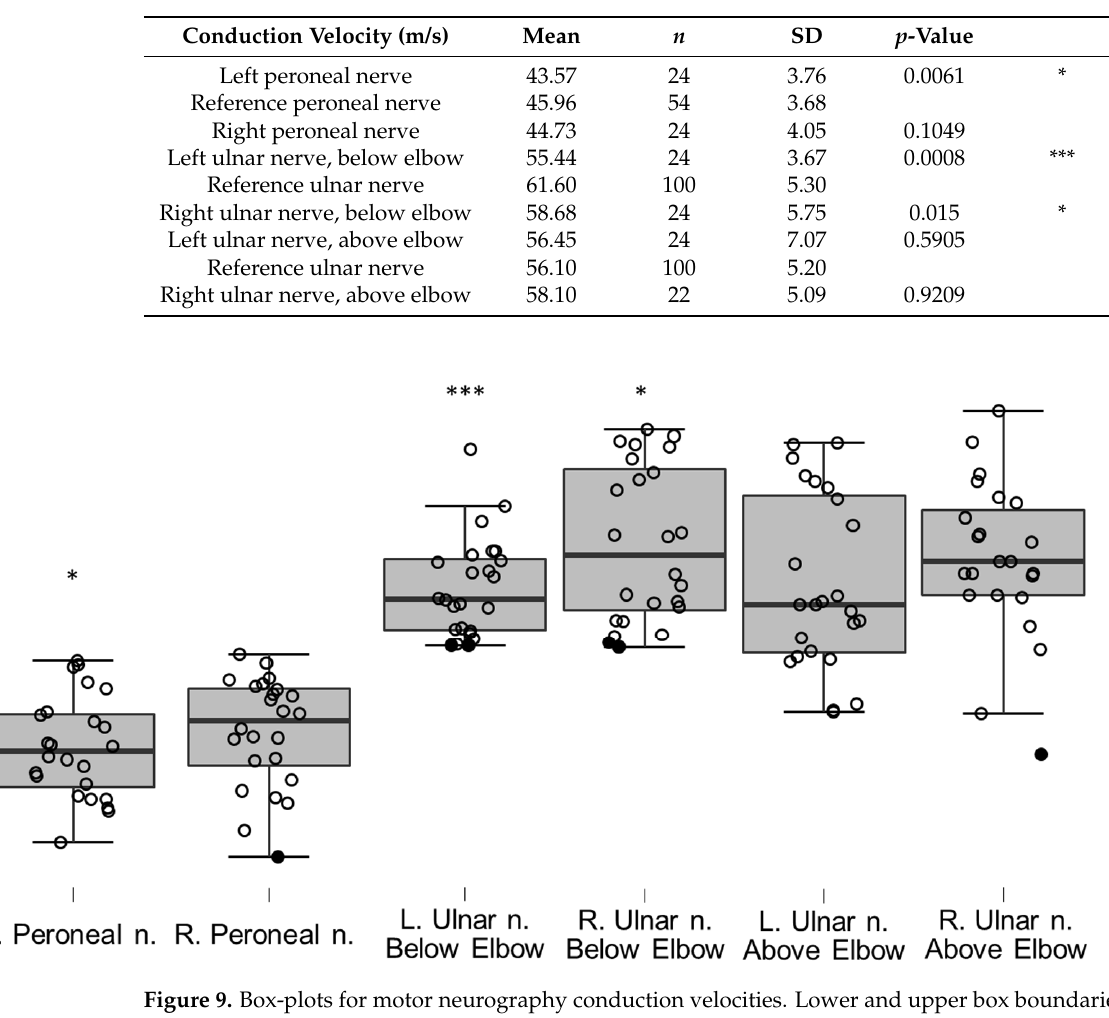
Table 7. Motor neurography conduction velocities (CV) for left and right peroneal and ulnar nerves. * and *** indicate statistically significant differences to reference material with p -values corresponding to Bonferroni corrected 0.05 and 0.001, respectively.